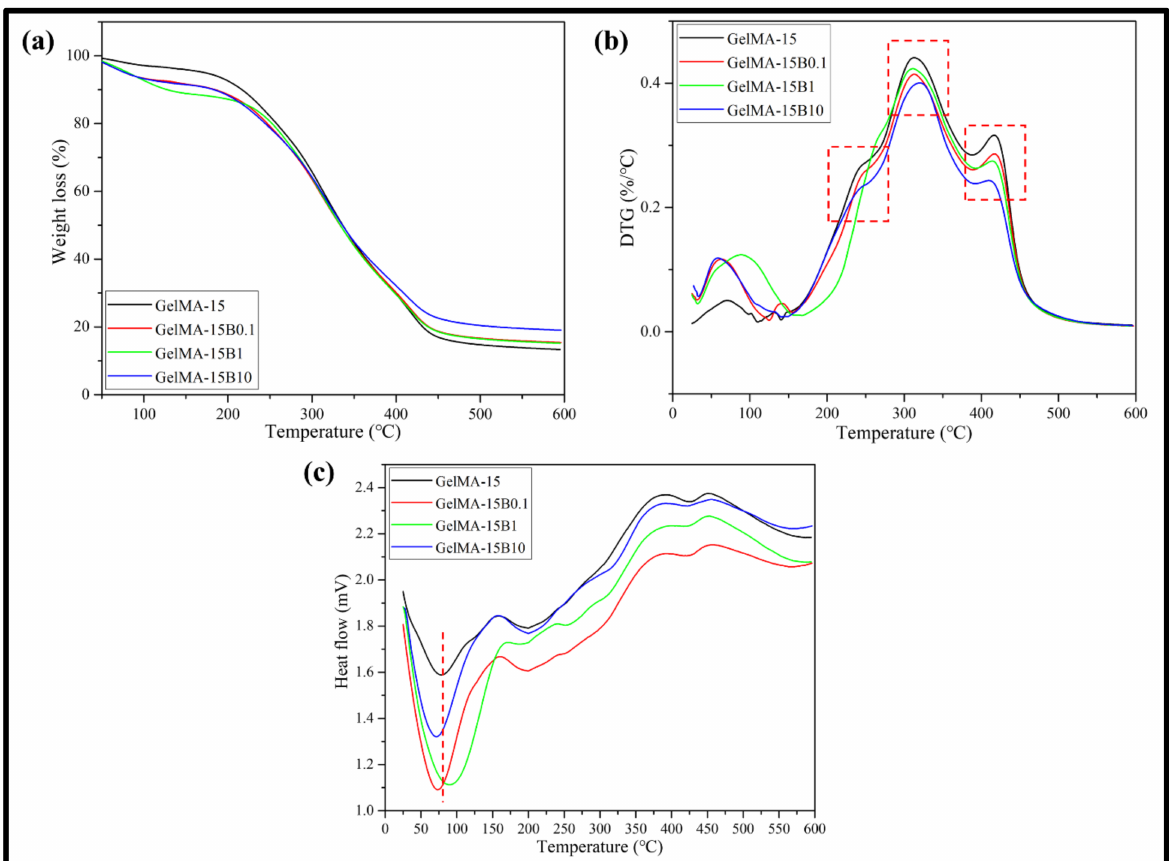
Figure 5. Thermal properties analysis of GelMA-15, GelMA-15B0.1, GelMA-15B1, and GelMA-15B10 hydrogels. ( a ) Thermo- gravimetric (TG) and ( b ) derived thermogravimetric (DTG) analysis. ( c ) Differential scanning calorimetry (DSC)